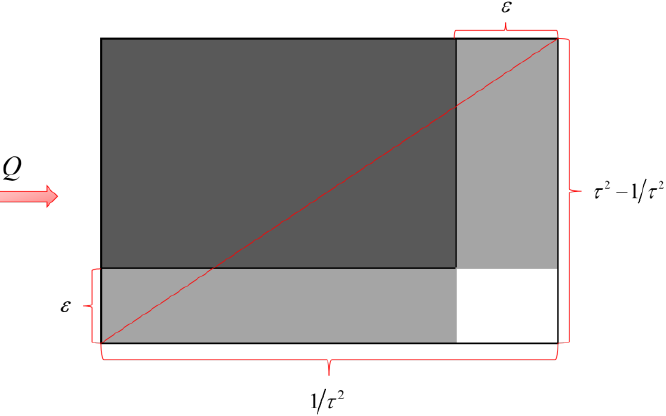
Figure 3. A geometric simplified model of the weight coefficient of the series-parallel model for representing unit on the longitudinal section.